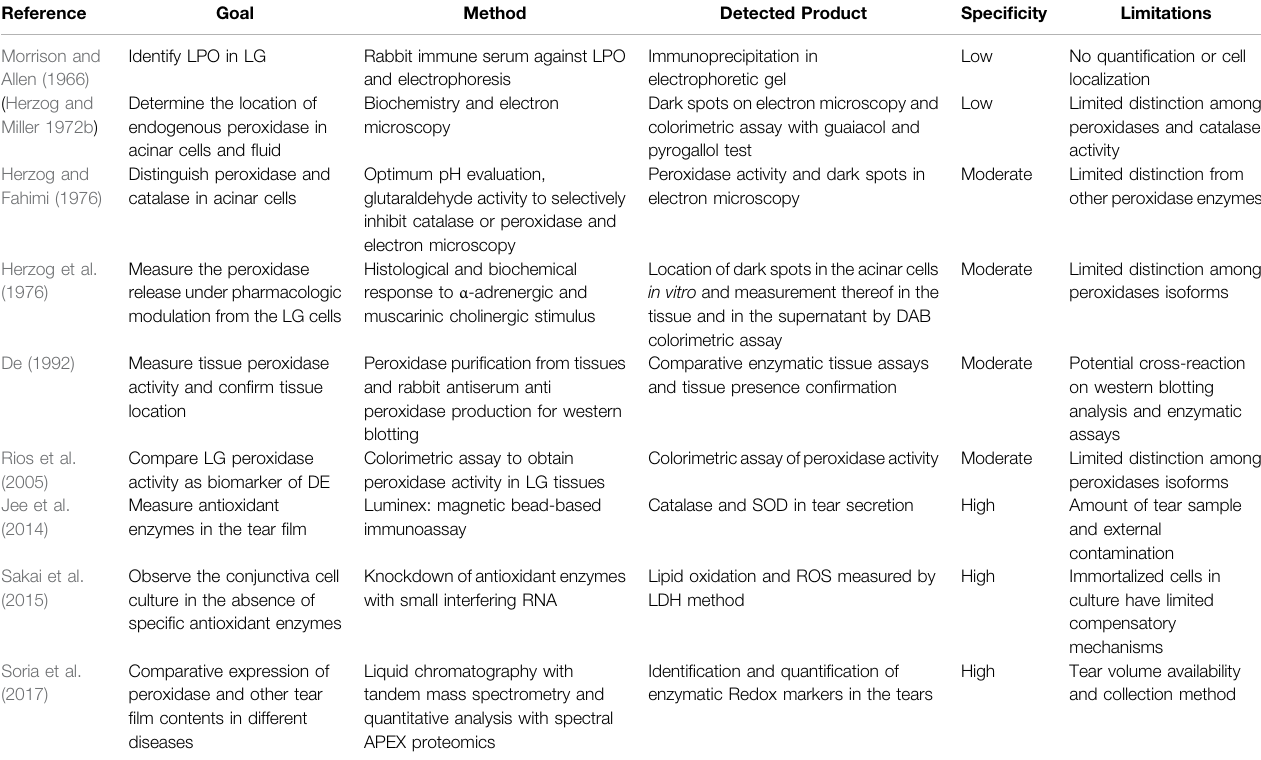
TABLE 2 | Assays and their limitations for OS, antioxidant or free radical scavenger expression or activity in the LG, tear fi lm or the ocular surface.